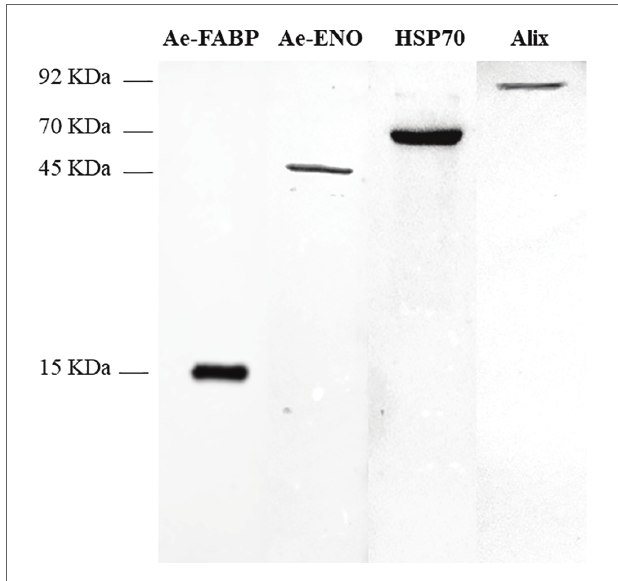
FIGURE 5 | Western blot analyses performed on exosome-like vesicles released from teratocytes stimulated with ATP. The incubation with anti- Ae -FABP (15 kDa) and anti- Ae -ENO antibodies (45 kDa) confirmed that both proteins are released by vesicles. The incubation with anti-HSP70 (70 kDa) and anti-ALIX (92 kDa) antibodies, specific exosomal markers, strongly supports the hypothesis that vesicles are